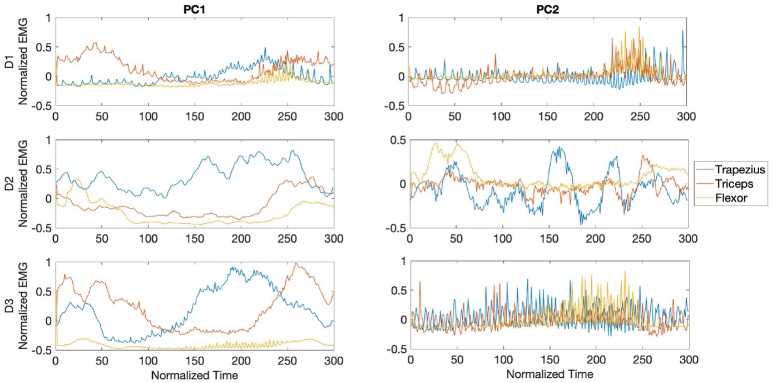
Waveforms showing the two principal components of muscle activation across the trapezius (blue), triceps (orange), and wrist flexor (yellow) muscles for drummers D1-3 in the transition phase (bottom left panel in Figure 7). Each panel shows the activation pattern centered around stroke onset (150 ms).